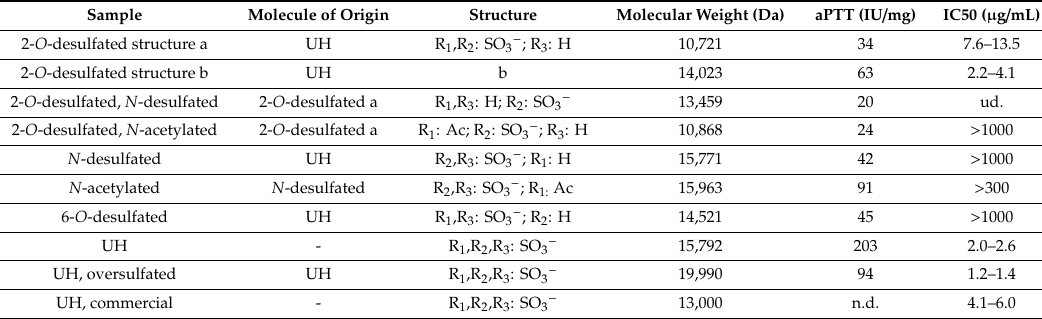
Figure 3. In vitro antimalarial activity of heparins with di ff erent sulfation patterns. ( a , b ) Structures obtained after desulfation (see Table 1 for the definition of chemical groups R 1 , R 2 , and R 3 ). IdoA: iduronic acid, GlcN: glucosamine, GalA: galacturonic acid. ( c ) In vitro P. falciparum growth inhibition activity assay of heparin fractions with di ff erent sulfation patterns. Table 1. Description of the heparin samples tested in Figure 3.